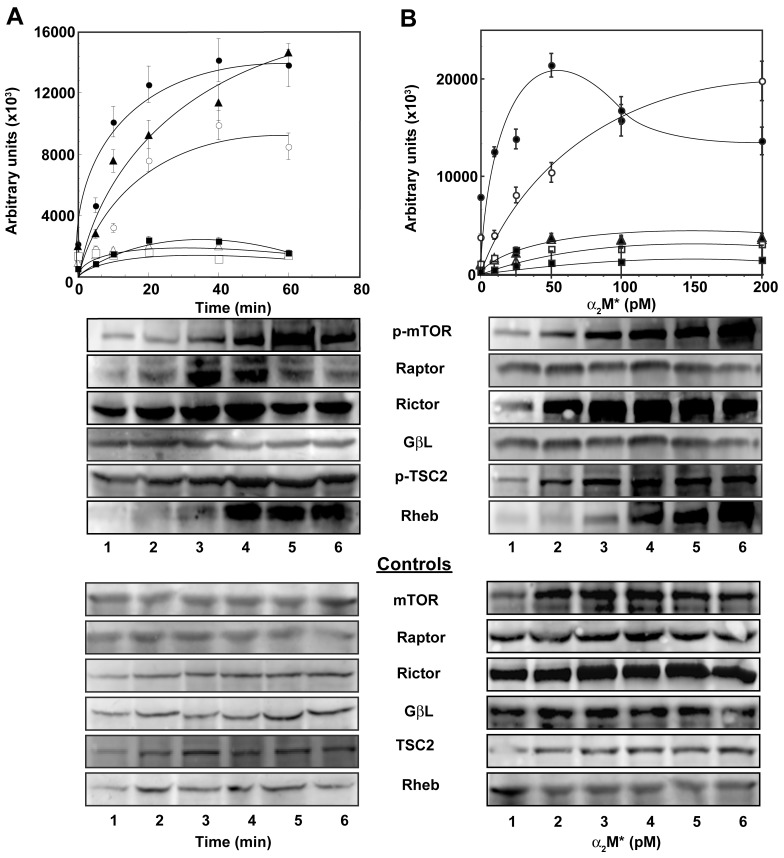
Effect of treatment of 1-LN prostate cancer cells with α2M* for varying periods of time (Panel A) or concentration (Panel B) on mTORC1 and mTORC2 interacting proteins.In Panel A is shown the effect of time of incubation of cells with α2M* (50 pM) and Panel B is shown the effect of varying concentrations of α2M* for 25 mins on expression of: p-mTORT2481 (O); Raptor (▵); Rictor (▴); GβL (□); p-TSC (•); and Rheb (▪) as determined by Western blotting. A representative immunoblot from three to five experiments is shown for each protein in Panel A and Panel B. The expression of these proteins is shown in arbitrary fluorescence units and is expressed as the mean ± SE from three to five independent experiments. Protein loading controls, either unphosphorylated target proteins or actin, were performed for both Panel A and Panel B are shown below the respective immunoblots.